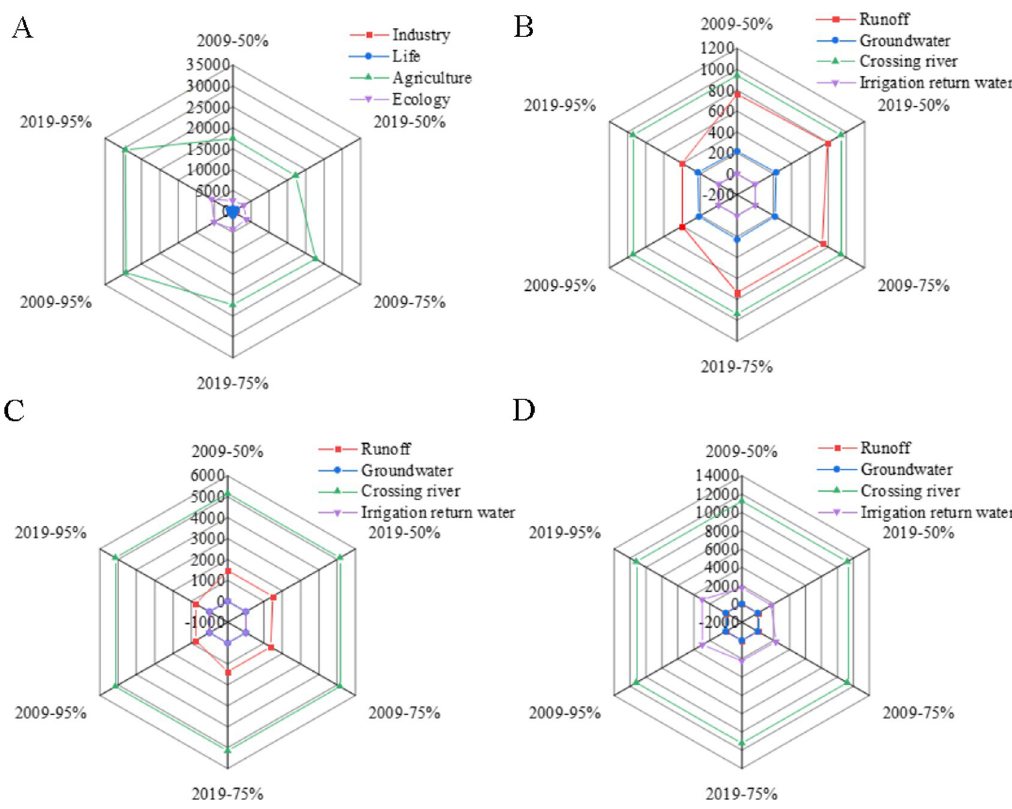
Fig 5. Water resources status of planning levels under different year parameters.